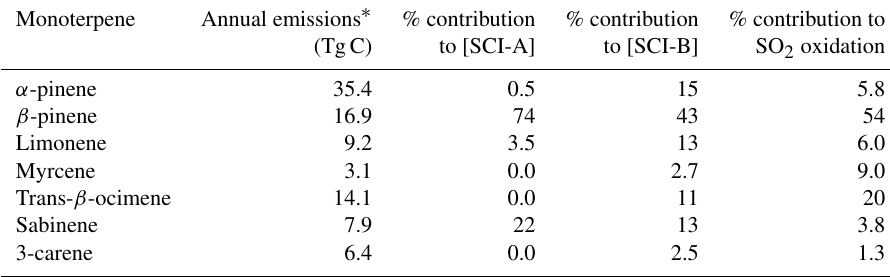
Table 6. Monoterpene contribution to [SCI] and SO 2 oxidation in the surface layer of the model simulation. Monoterpene Annual emissions ∗ % contribution % contribution % contribution to (TgC) to [SCI-A] to [SCI-B] SO 2 oxidation α -pinene 35.4 0.5 15 5.8 β -pinene 16.9 74 43 54 Limonene 9.2 3.5 13 6.0 Myrcene 3.1 0.0 2.7 9.0 Trans- β -ocimene 14.1 0.0 11 20 Sabinene 7.9 22 13 3.8 3-carene 6.4 0.0 2.5